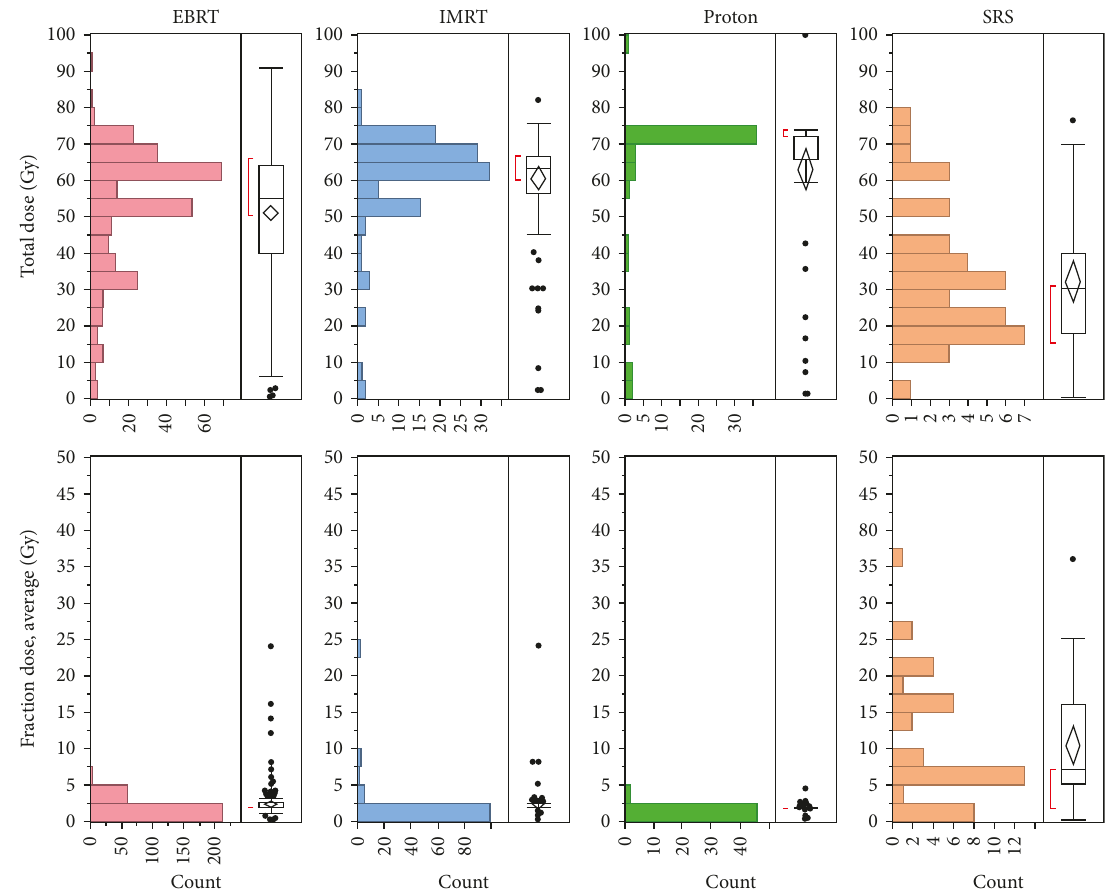
Figure 1: Distributions for total radiation doses (top row) as well as fraction doses (bottom row) for each radiation modality. Stereotactic radiosurgery (SRS) is typically given as high-dose fractures for a lower total